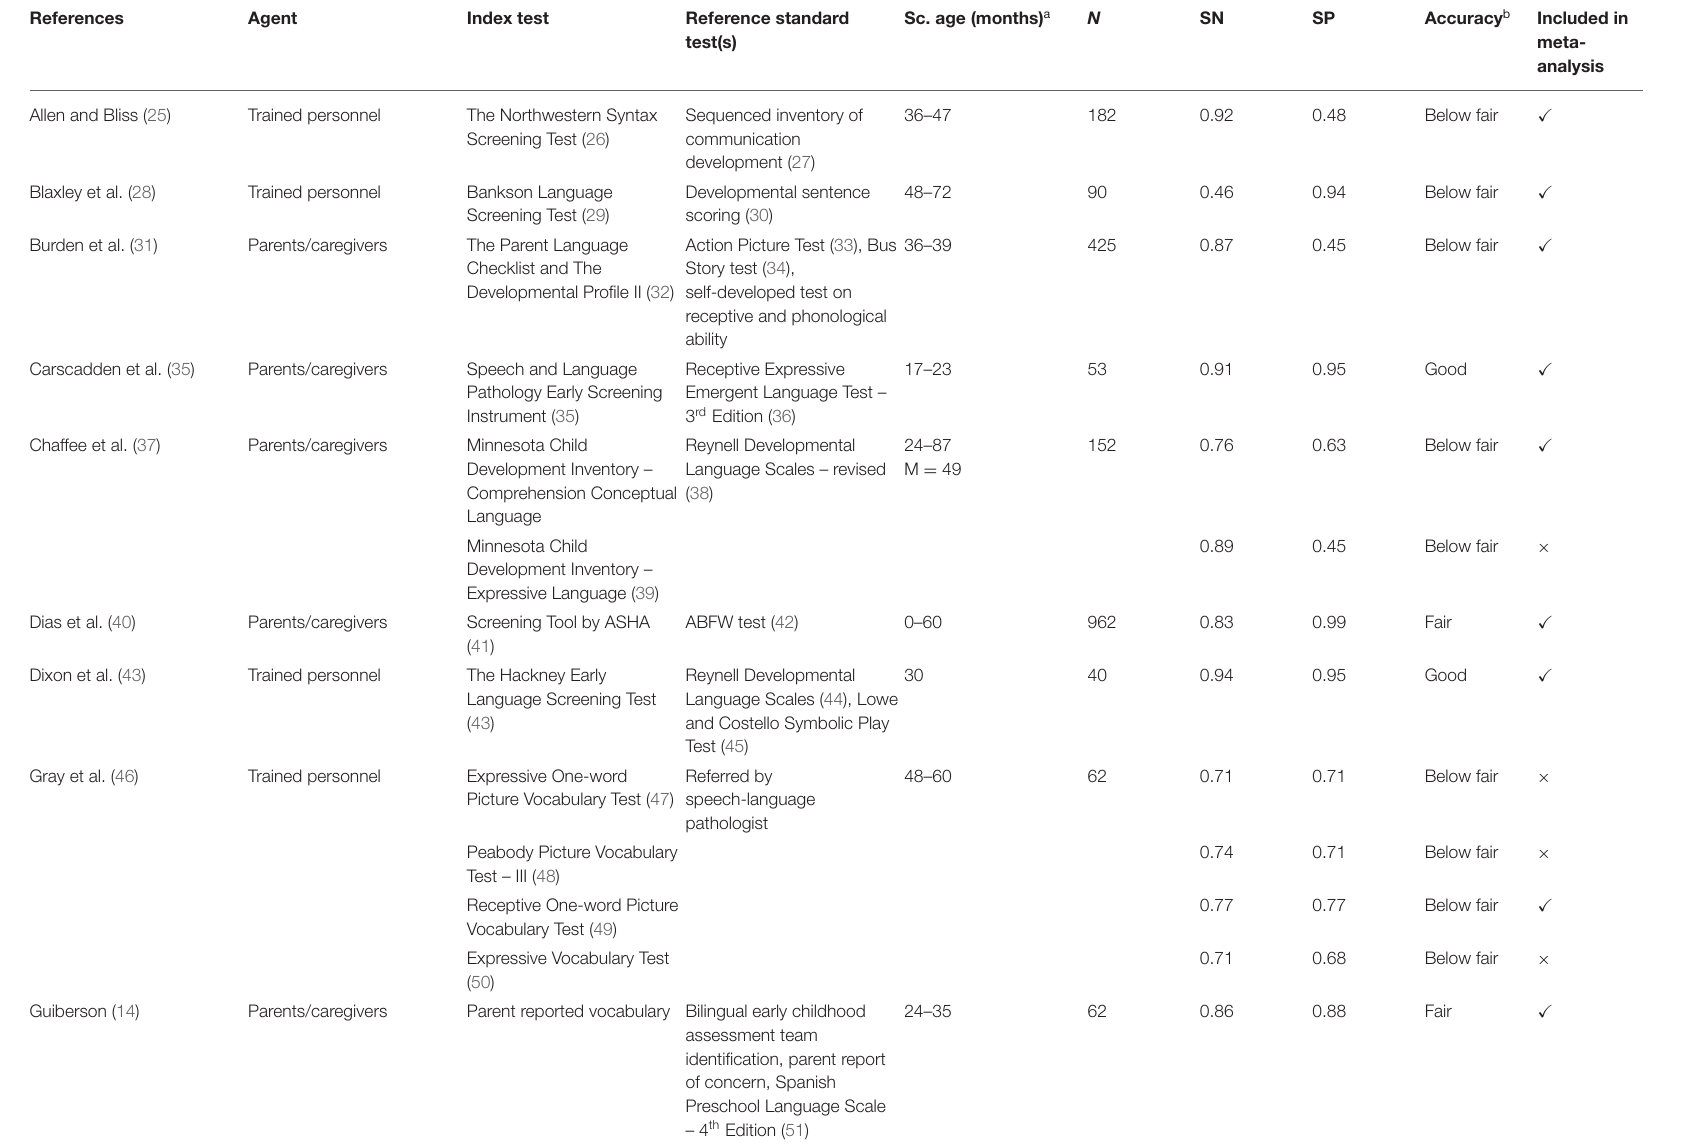
TABLE 1 | Studies involving tools based on a child’s actual language